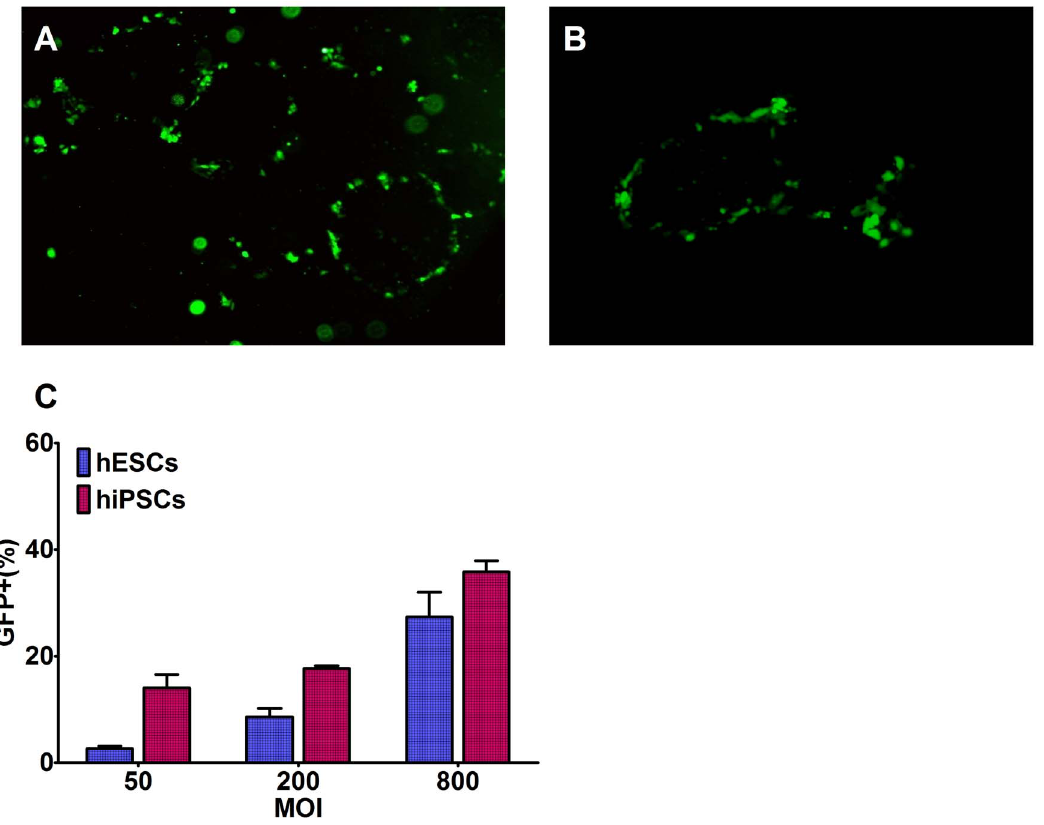
Figure 2. Infection efficiency of recombinant baculovirus in hESCs and hiPSCs. A and B : Fluorescence microscopy images of hESCs and hiPSCs, respectively, which were seeded at 1 6 10 5 cells per well and infected with Bac-GFP at MOI=200 (40 6 ). C : GFP + % of Bac-GFP-infected hESCs and hiPSCs at 24 hpi with different MOIs. Results are means 6 SD (n=3). Abbreviations : hESCs, human embryonic stem cells; hiPSCs, human induced pluripotent stem